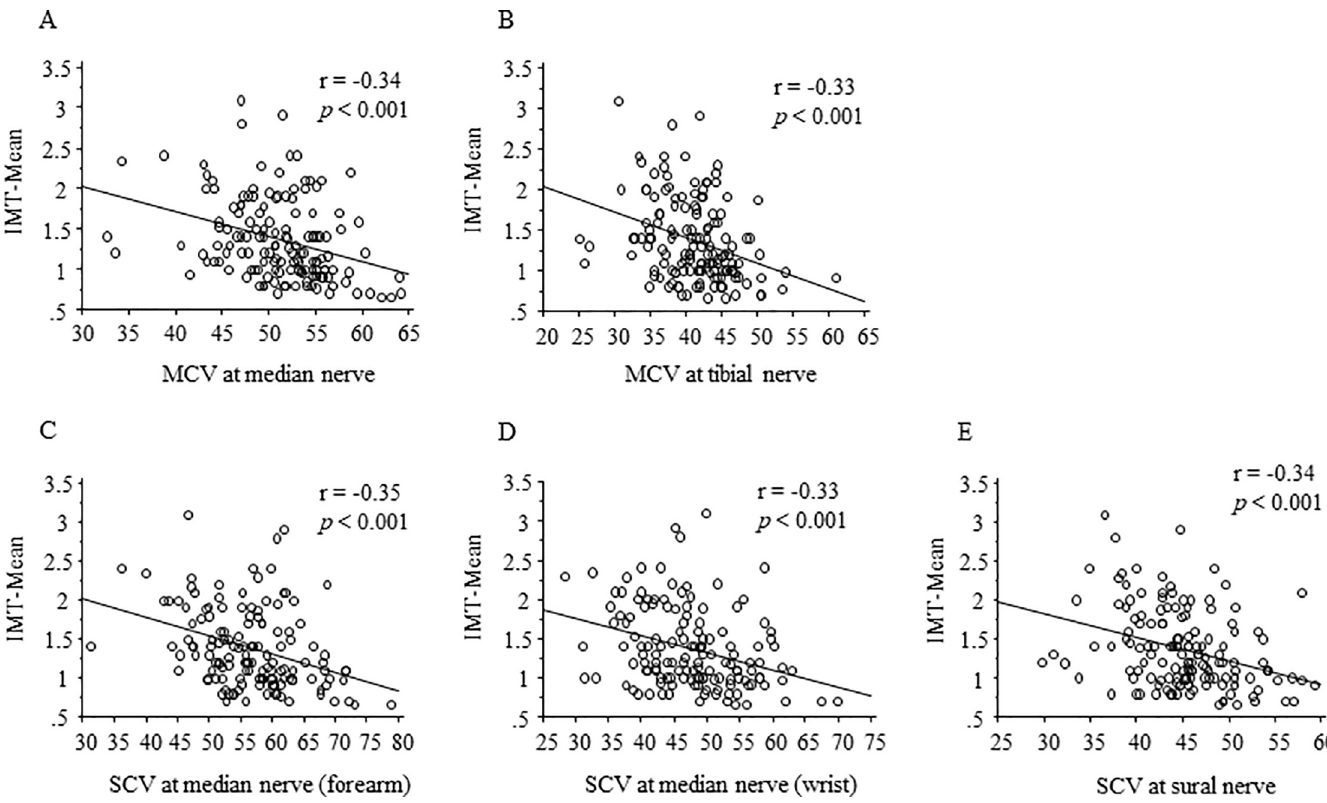
Fig 1. Correlation between NCV and IMT-Mean. NCV at all sites were significantly and inversely correlated with IMT-Mean. (A) MCV at median nerve, (B) MCV at tibial nerve, (C) SCV at median nerve (forearm), (D) SCV at median nerve (wrist), (E) SCV at sural nerve.